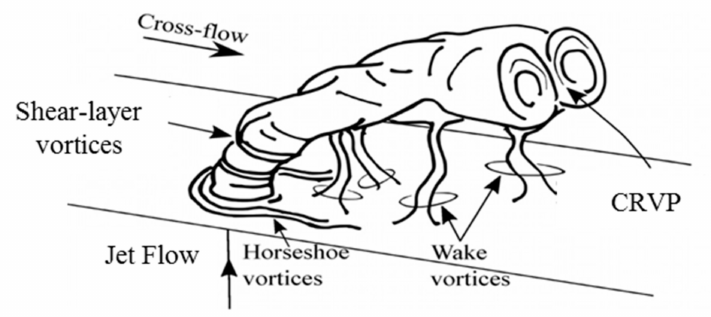
Figure 6. Schematic of the four fundamental vortical structures evolved in a JICF as presented by Fric and Roshko